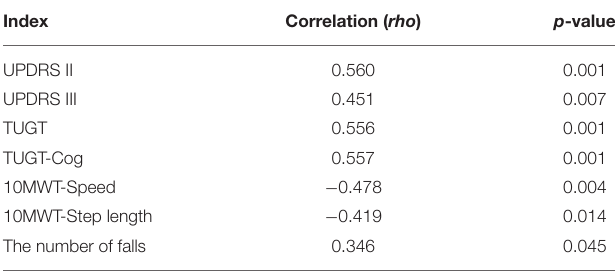
TABLE 3 | FOGQ-CH correlations with